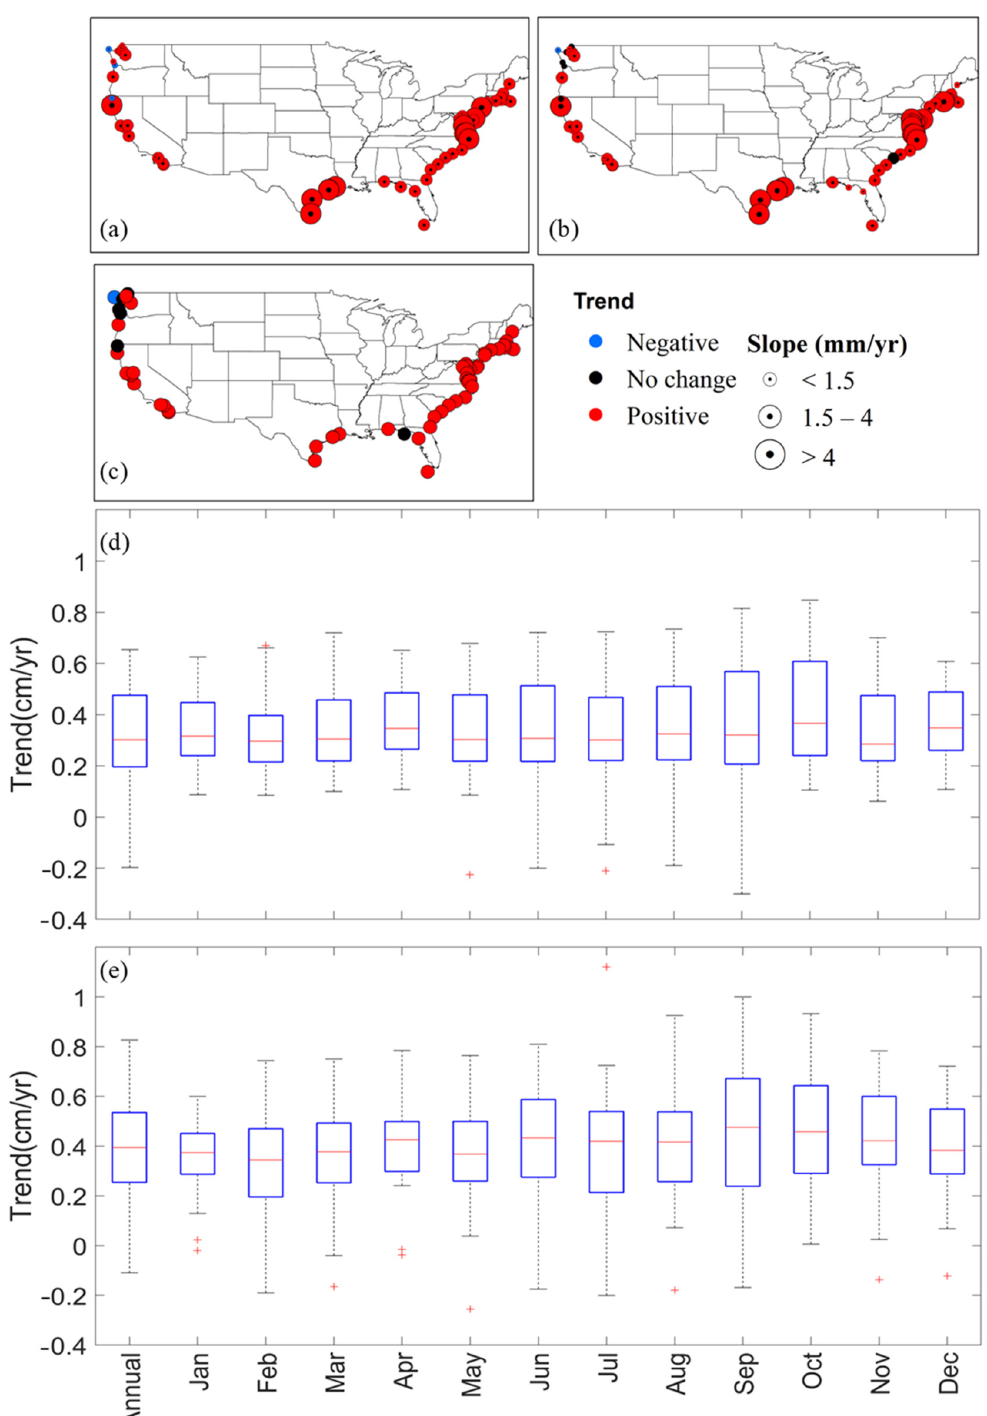
Figure 2. Spatial plots showing the trend significance of annual sea level along the coastal US at the statistical significance of p ≤ 0.05 ( a ) National Ocean and Atmospheric Administration (NOAA) ( b ) Mann–Kendall without autocorrelation (MK1) trend. The trend is shown in red, blue, and black colors. The magnitude of the trend is represented by graduated symbols in ( a , b ). ( c ) Significance of annual trend after accounting short-term persistence (STP) ( d ) Box plots of the trend magnitudes corresponding to the sea level stations showing a significant MK1 trend (95% confidence level) for annual and all months ( e ) distribution of trend magnitude of latest available 30-year data. Each whisker shows the outliers, each red line shows the median, and each box represents the values within the 25th and 75th percentile of the sea level trend magnitude for each month. The positive (+) and negative sign ( − ) represents positive and negative trend respectively.